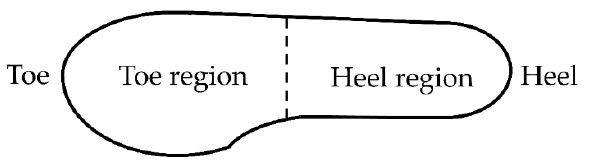
Figure 5. To investigate the tendency to load the skis, the foot was divided into two regions: toe and heel.